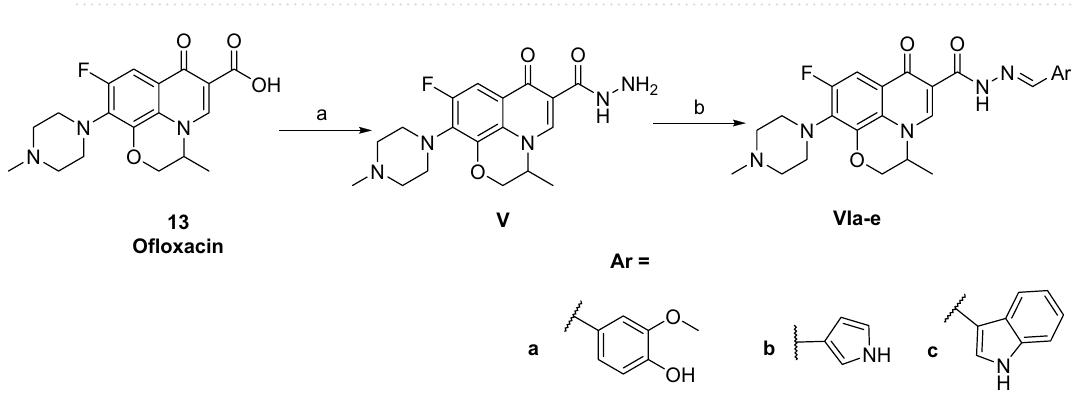
Figure 5. Synthetic pathway of moxifloxacin derivatives. Generated using ChemDraw 2021 (https:// perki nelme rinfo rmati cs. com/ produ cts/ resea rch/ chemd raw) 19 . Reagents and conditions: (a) NH 2 NH 2 80%, reflux, 24 h (61%); (b) C 6 H 5 COCH 3 , ethanol, reflux, 6 h (48%); (c) ArCHO, ethanol, reflux, 6 h (20–88%); (d) phthalic anhydride, acetic acid, reflux, 12 h (80%).